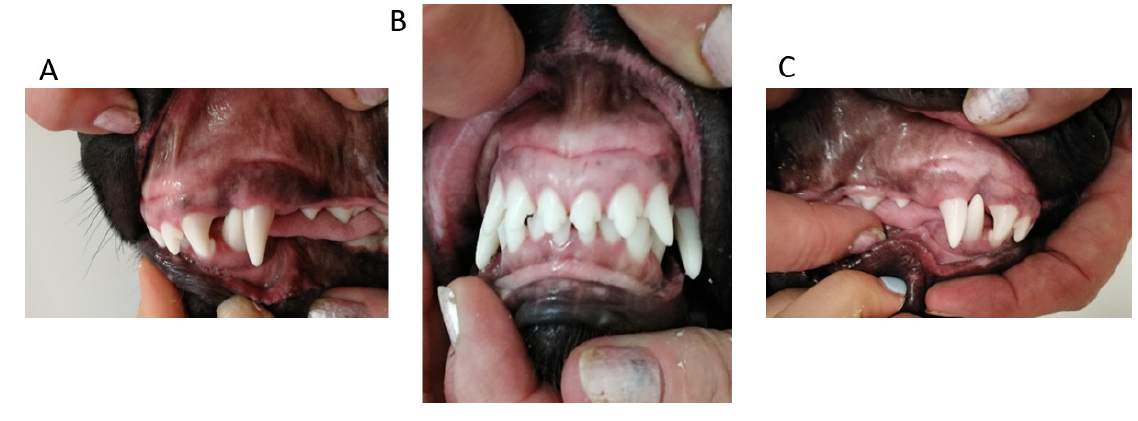
Figure 1. First case. Occlusion before treatment. ( A ) left side, ( B ) en face, ( C ) right side.